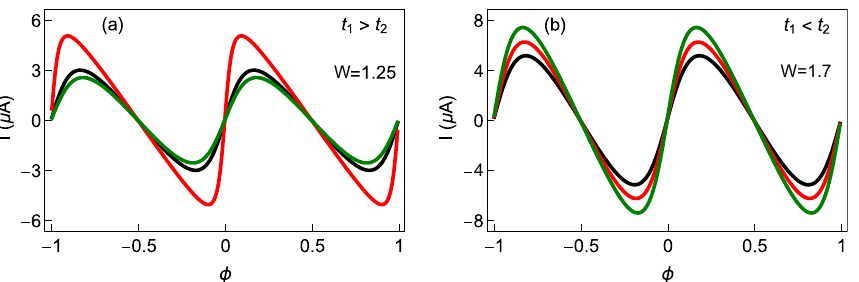
Figure 8. Persistent current as a function of AB flux φ at different values of φ ν for ( a ) non-staggered and ( b ) staggered AAH SSH rings, in the half-filled band case, considering N = 12 . In each plot, the black, red, and green colors are associated with φ ν = 0 , π/ 3 , and π/ 2 ,